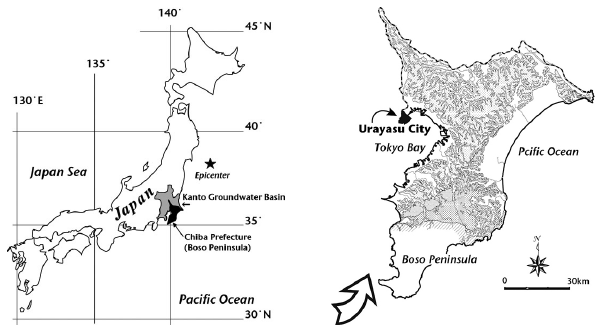
Figure 1. Location of Urayasu City and the epicenter of the 2011 Tohoku